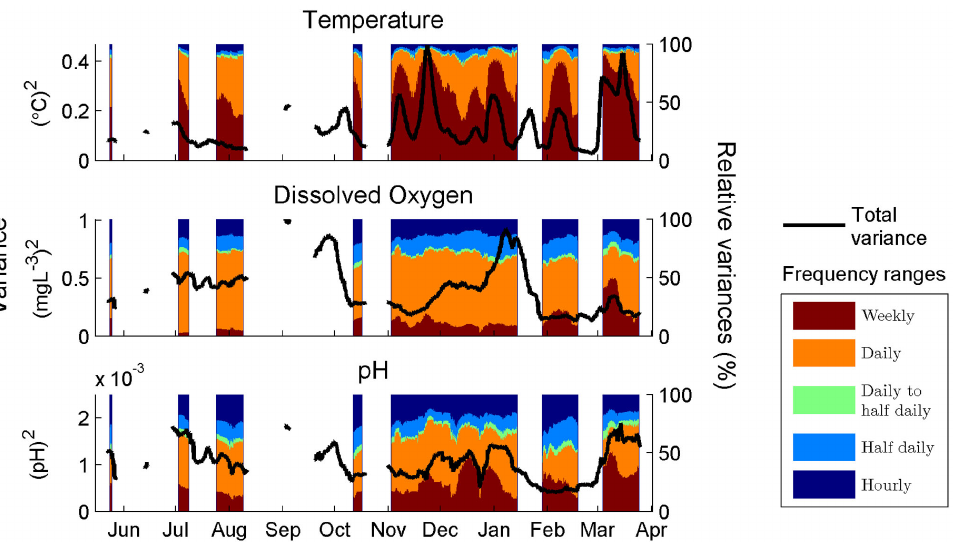
Figure 3. Time series of decomposed variances. Variance decomposition of temperature, dissolved O 2 concentration and pH in the long-term time series station, obtained using a running window of two weeks. Left axes scale absolute variances (black lines), and right axes the relative contribution (in %) of each frequency range to total variance. To perform the spectral analyses the time-series need to be uninterrupted; thus short gaps in the signals resulted in the long gaps observed in the figure.